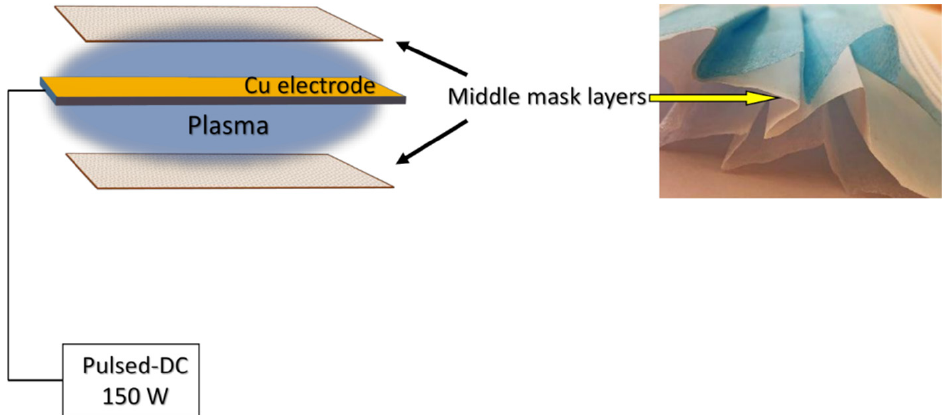
Figure 1. Experimental set up of CuO synthesis on the middle mask layer.